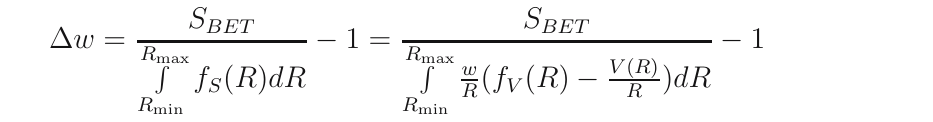
Fig. 2 S BET as a function of the maximal p / p p / p ) used on calculation of the S BET values for MCM-41 (sample 2), MCM-48 and 0 ,max